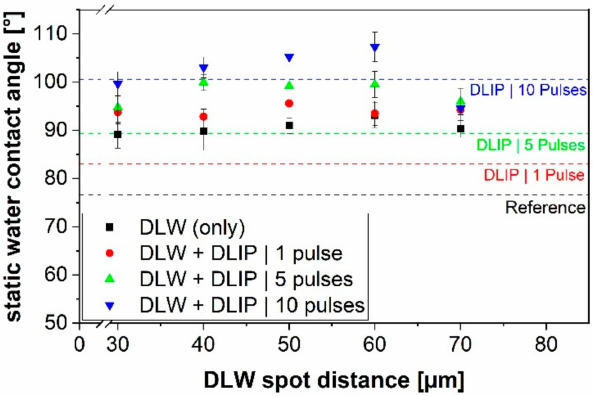
Figure 10. Measured static water contact angle on PET foils imprinted with different single- and multi- scale structures. Multi-scale structures were processed combining the DLW and DLIP techniques. Single-scaled DLW structures are shown as black values, whereas single-scaled DLIP structures are represented with dashed lines. Error bars indicates the mean value of 5 measurements. Black dashed line represents the reference on a flat PET